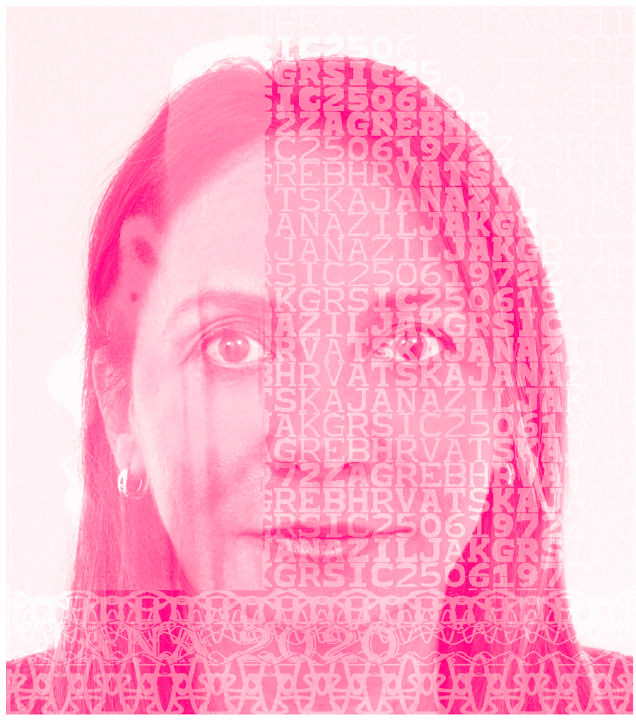
Figure 11. Magenta channel (M).